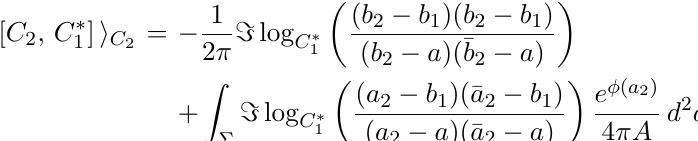
and C (cid:3) 1 2